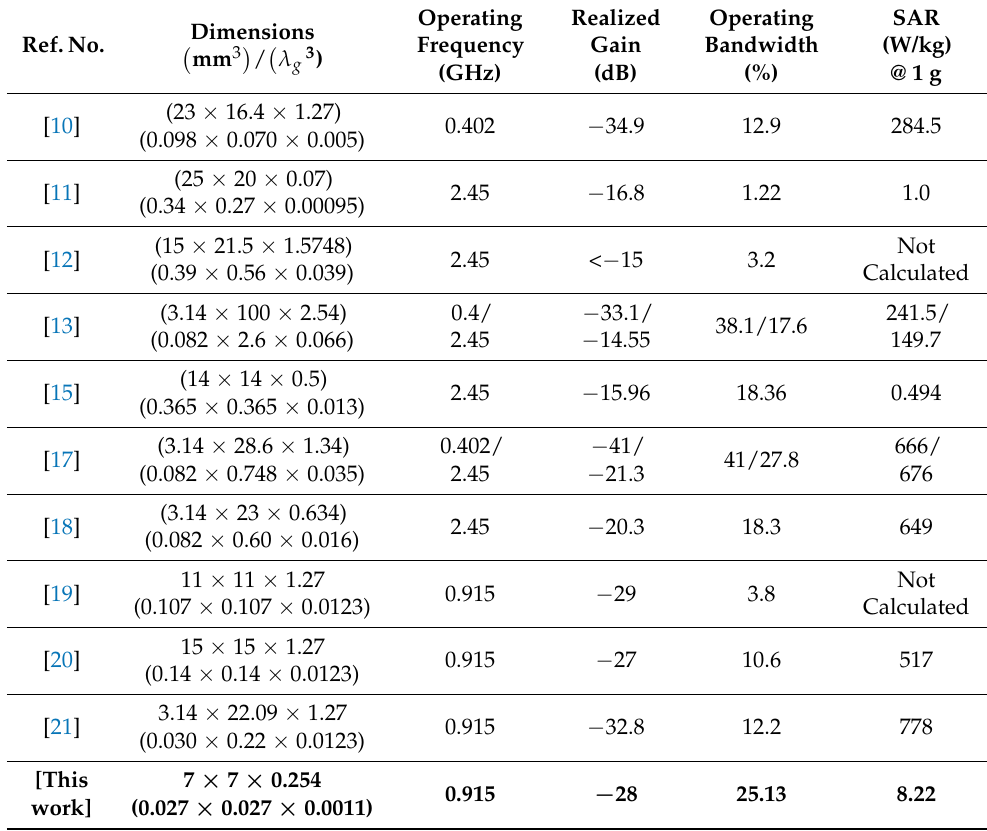
Table 2. A comparison of the proposed antenna’s performance to that of recent work.